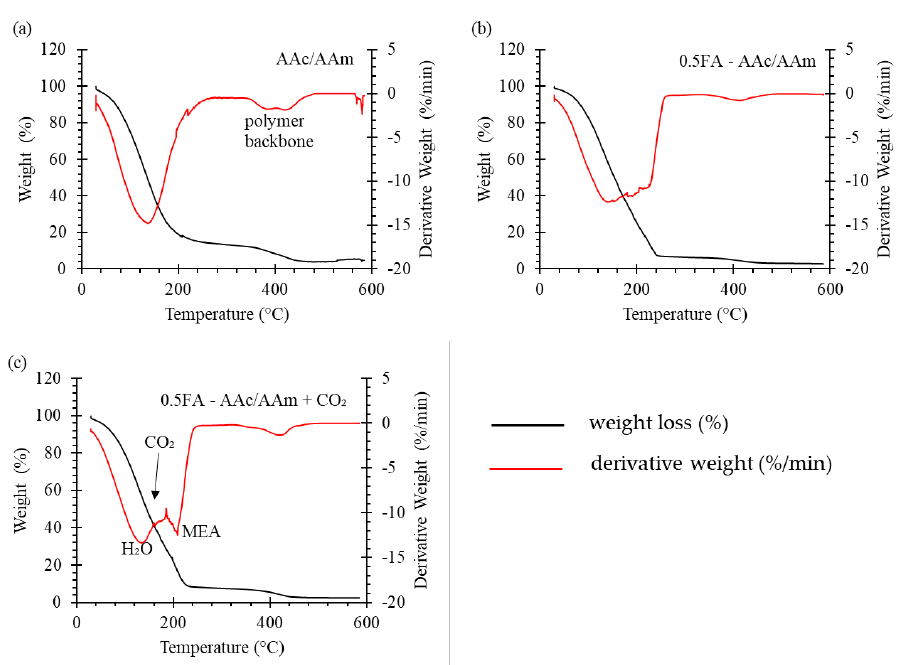
Figure 4. TGA and DTG curves of ( a ) AAc/AAm hydrogel, ( b ) 0.5FA-AAc/AAm composite hydrogel and ( c ) CO 2 pre-saturated 0.5FA-AAc/AAm composite hydrogel. and ( c ) CO 2 pre-saturated 0.5FA-AAc/AAm composite